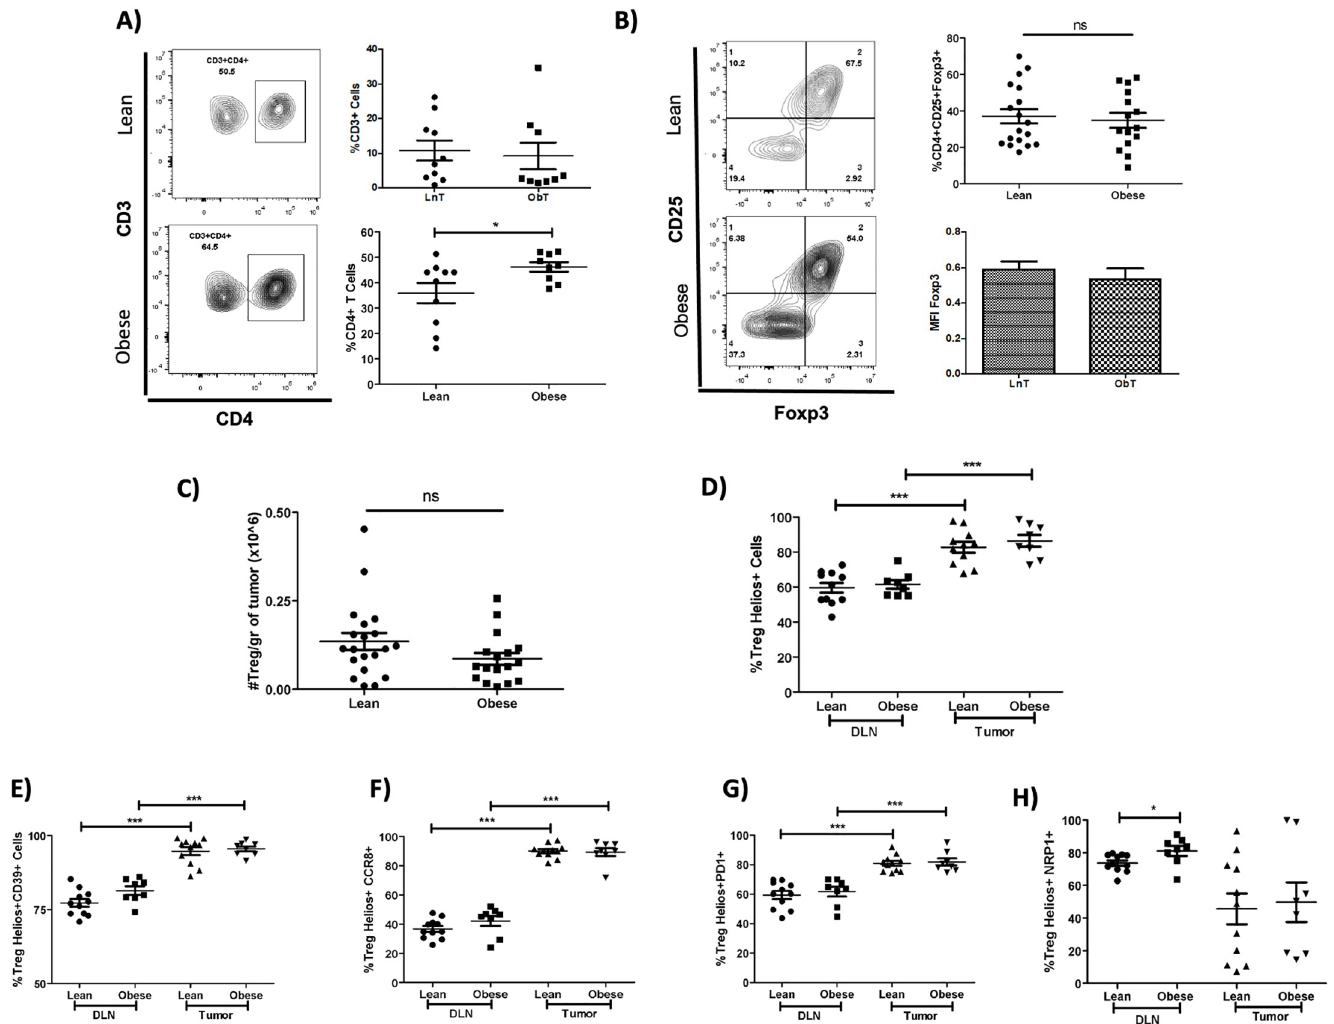
Fig 3. High fat diet does not alter the frequency, number, or phenotype of intratumoral regulatory T cells. Representative dot plots (left) and frequencies (right) of tumor infiltrating A) CD4+ T cells and B) CD4 + CD25 + Foxp3 + regulatory T cells in lean (upper plot, circles) and obese (lower plot, squares) mice 3 weeks after